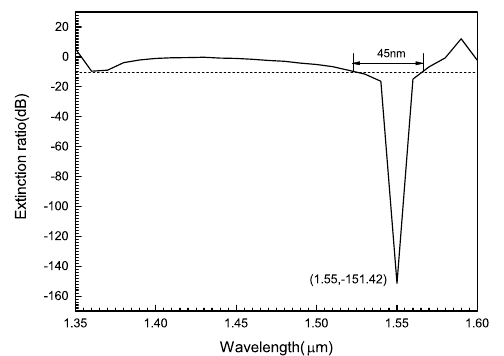
Figure 9. Evolution of circular double-core PCF extinction ratio with operating